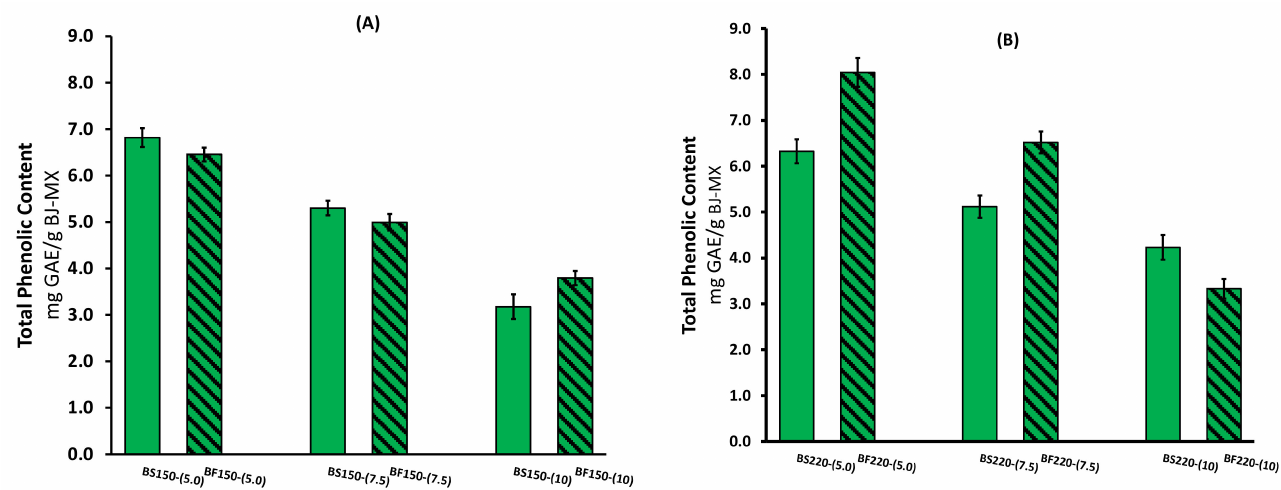
Figure 1. Total phenolic content of spray-dried broccoli juice–maltodextrin (BJ-MX) powders under different experimental conditions. Inlet temperature of ( A ) 150 ◦ C, and ( B ) 220 ◦